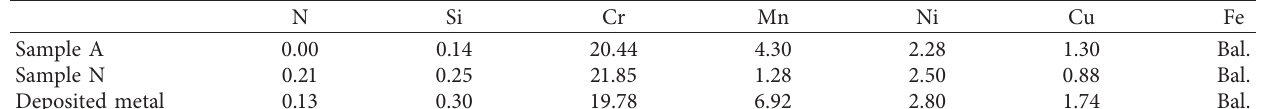
Figure 4: High-temperature microstructure: (a) sample A crystallized at 1528; (b) δ phase of sample A at 1310 ° C; (c) sample A 962 ° C δ ⟶ c phase transition at 962 ° C; (d) sample N crystallized at 1468 ° C; (e) δ phase of sample N at 1454 ° C; (f) sample N is in δ ⟶ c phase transition at 1415 ° C. Table 3: Surface EDS analysis results (wt.%).